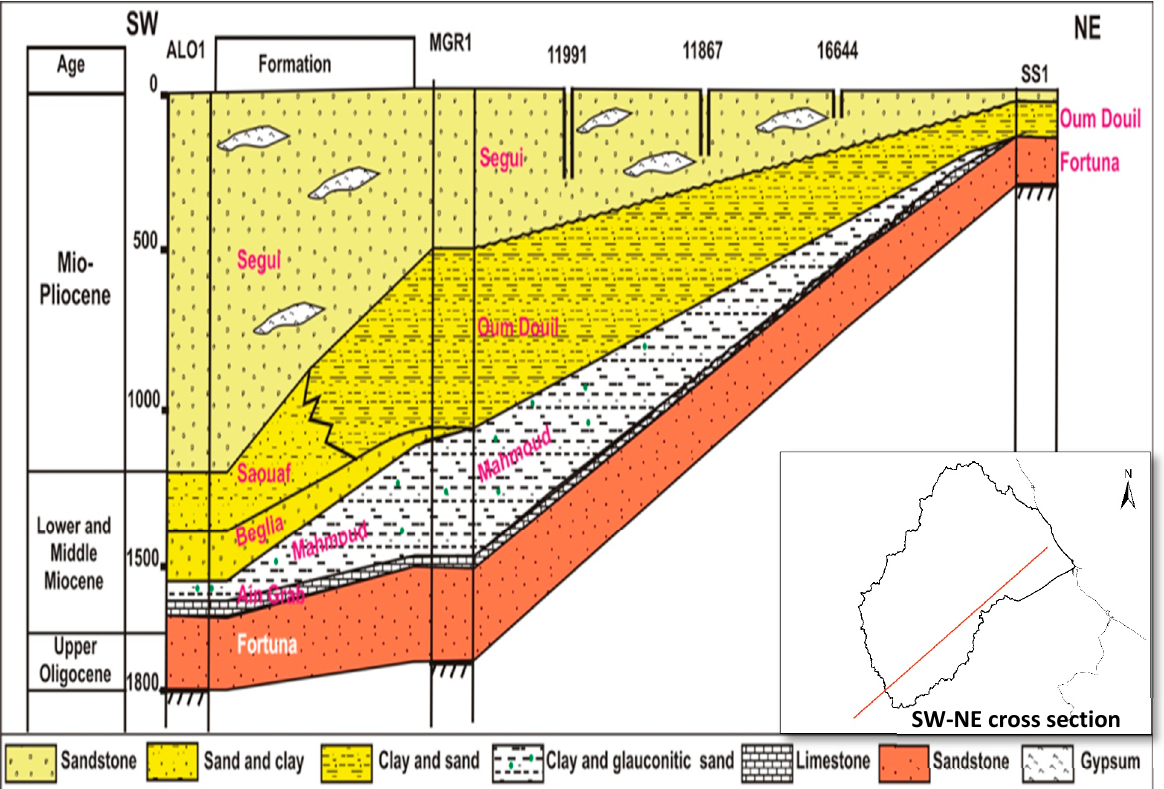
Figure 3. Hydrogeologic cross section SW–NE of the study region.